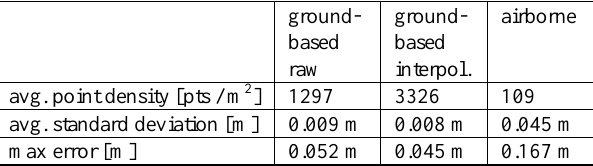
Table 1. Typical point densities of different point cloud data sets together with their accuracies (standard deviations and max difference from a plane fitted into the respective point